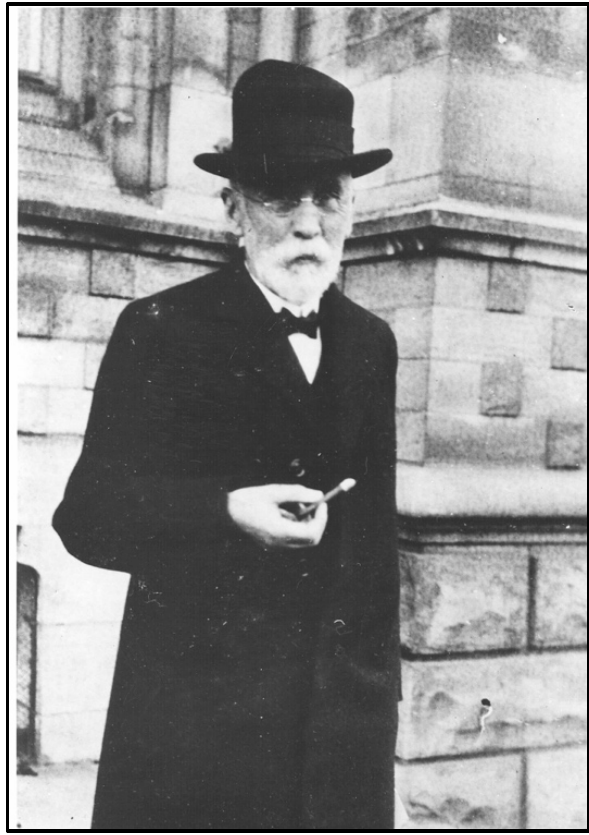
Figure 6. Hendrik A. Lorentz in 1927. Courtesy the Niels Bohr Archive,